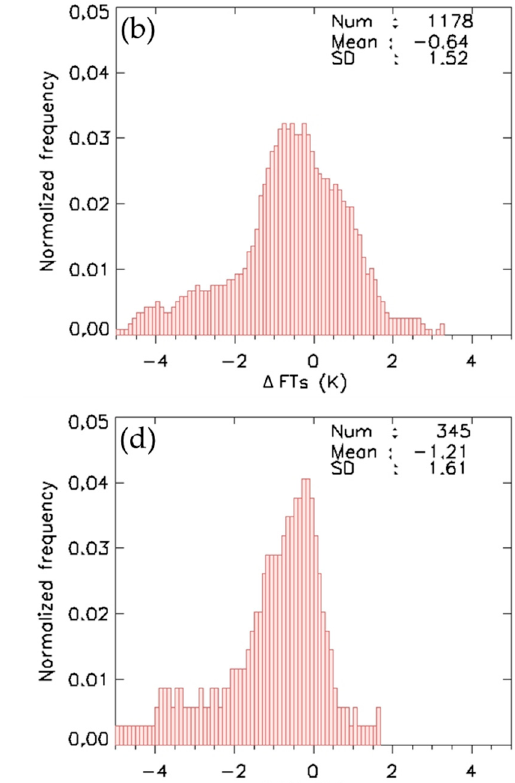
Figure 5. Frequency distribution of the optical/textural properties of fog pixels in the training cases at nighttime ( a , b ) and daytime ( c , d ). ( a ) Dual Channel Difference (DCD), ( b , d ) Difference between the BT of the fog top and surface temperature ( Δ FTs), and ( c ) Difference between the reflectance of 0.64 μ m (VIS0.6) and Vis_Comp ( Δ VIS).